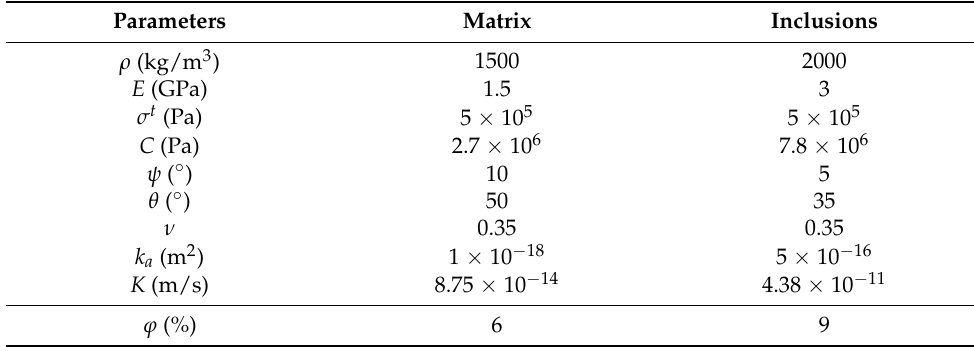
Table 3. Mechanical and hydraulic parameters for numerical simulation. Parameters